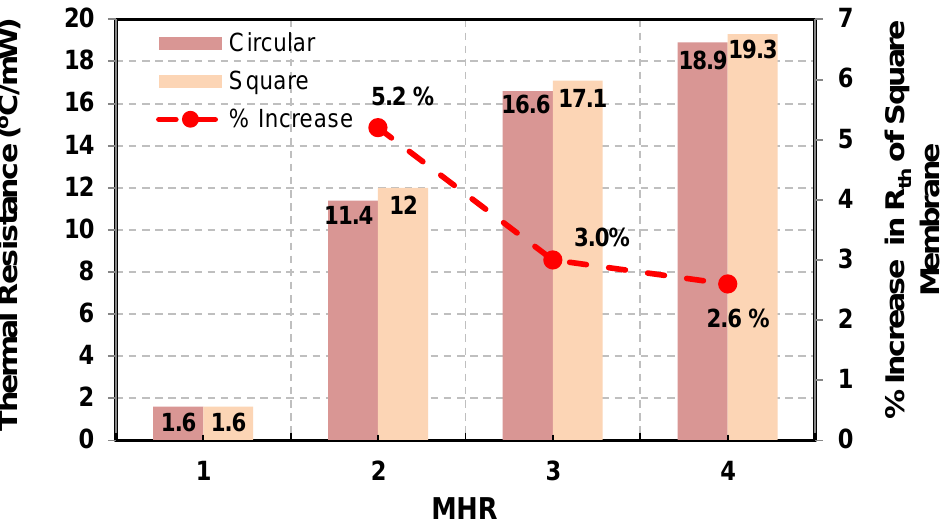
Figure 13. Thermal resistance (left y-axis) of square and circular membranes as a function of MHR compared on the bar graphs. Square membranes have relatively better thermal resistance. However with increasing MHR s, the % difference of thermal resistance between square and circular membranes (right y-axis) reduces significantly as shown by the line graph.